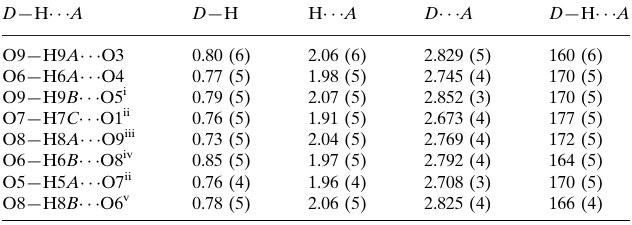
Hydrogen-bond geometry (A˚ , (cid:3)